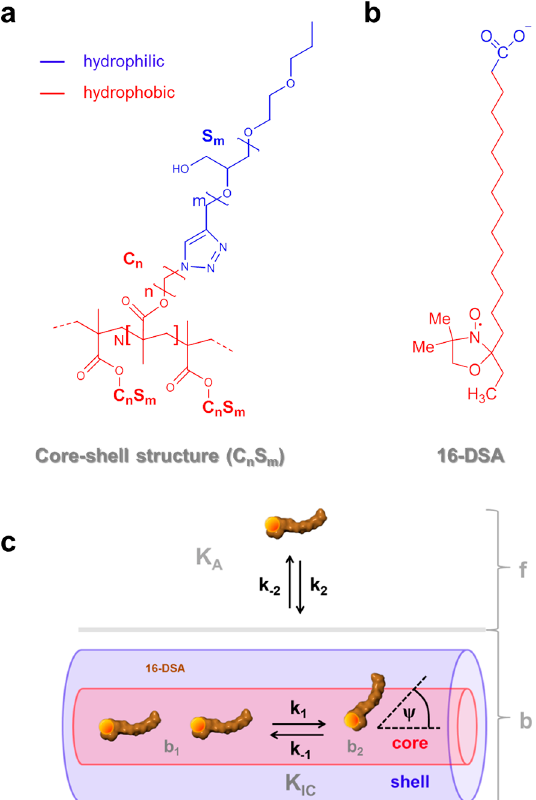
Figure 1. Chemical structure of the amphiphilic self-organizing components and essential dynamic regimes of 16-DSA. ( a ) Amphiphilic core-shell polymers C n S m with degree of polymerization N and ( b ) the amphiphilic 16-DSA (16-doxyl stearic acid) spin probe bearing a paramagnetic nitroxide